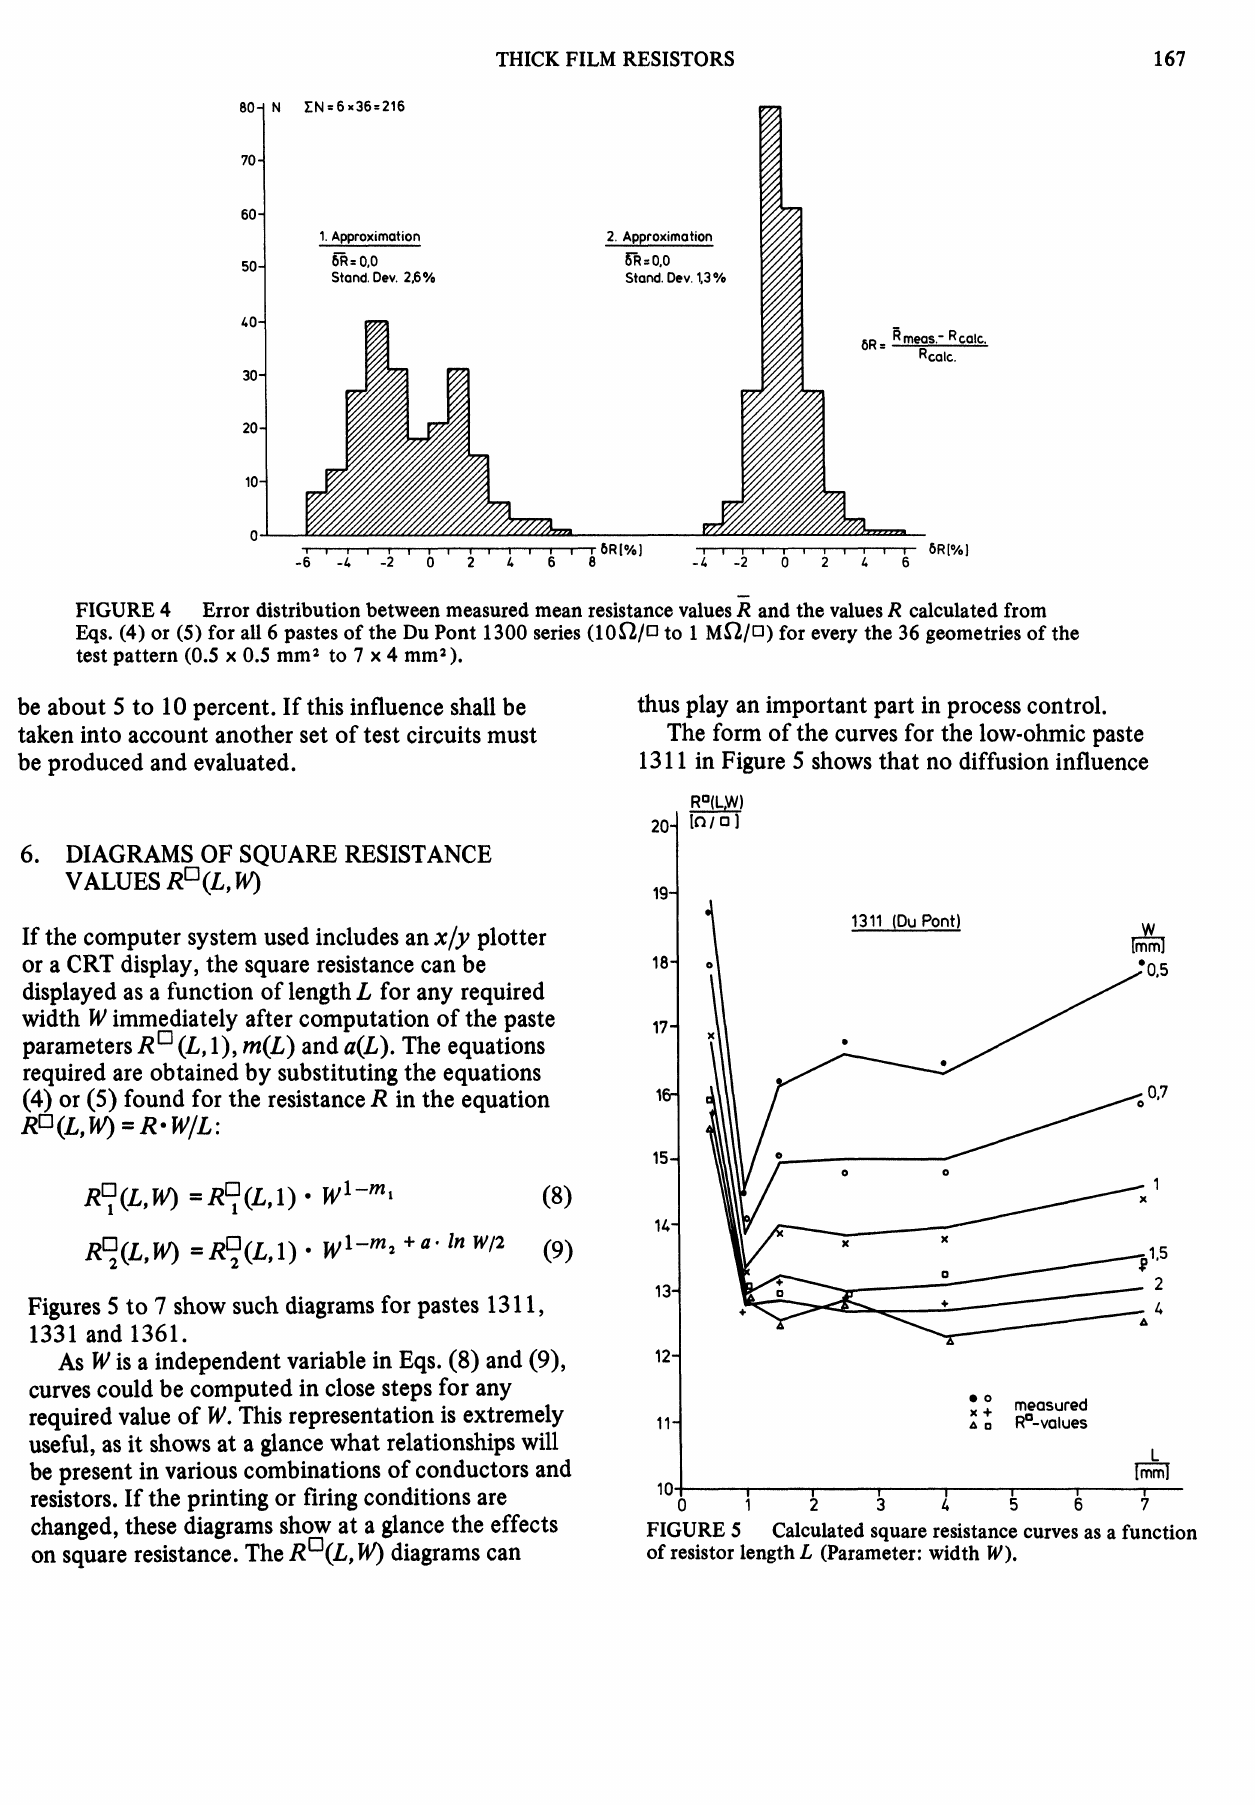
Calculated square resistance curves as a function of resistor length L (Parameter: width